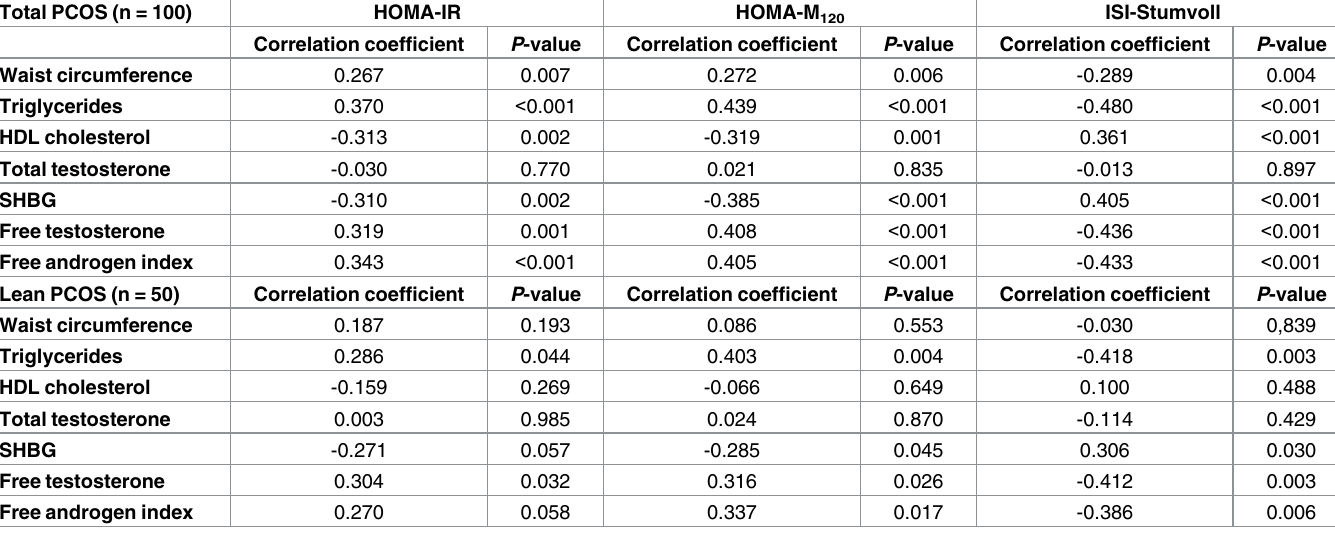
Table 4. Correlation analysis between insulin resistance indices and metabolic and hormonal parameters in women with polycystic ovary